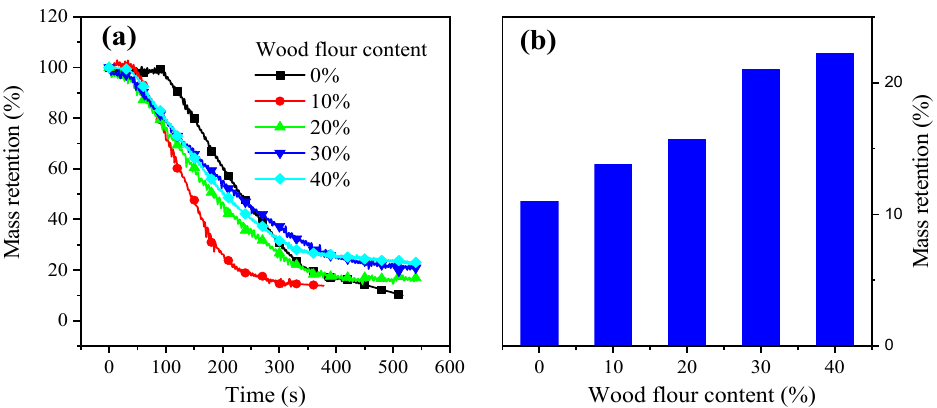
Figure 1. Heat rate release (HRR) ( a ), total heat release (THR); ( b ), smoke production rate (SPR); ( c ), total smoke production (TSP); ( d ), and curves of wood-PC composites.